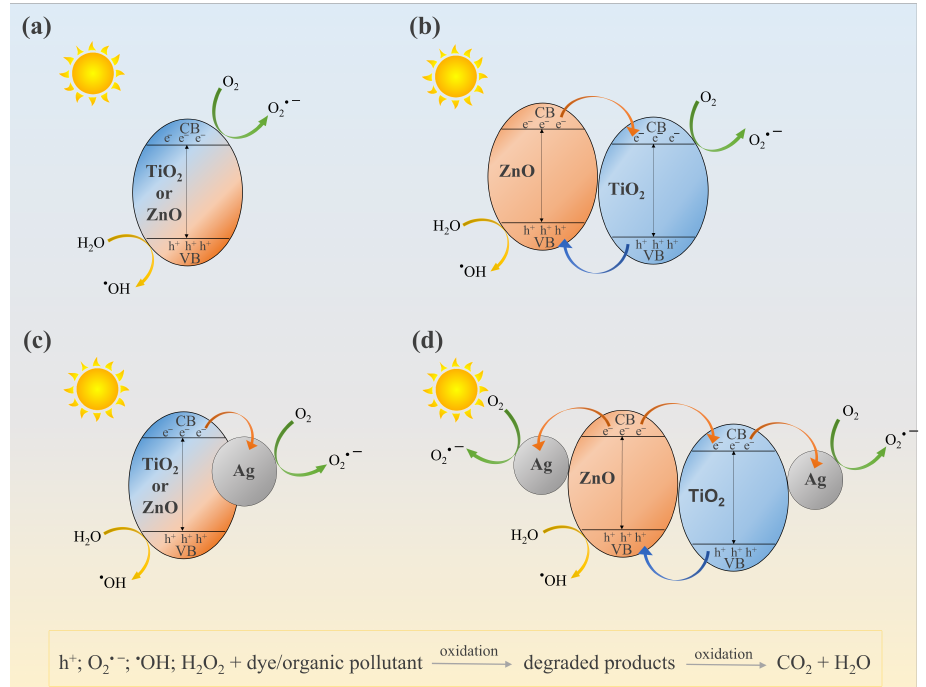
Figure 10. Schematic presentation of the proposed photocatalytic mechanisms of TiO 2 or ZnO ( a ), TiO 2 + ZnO ( b ), TiO 2 /Ag or ZnO/Ag ( c ) and TiO 2 + ZnO/Ag ( d ) composites on the chemically modified cotton